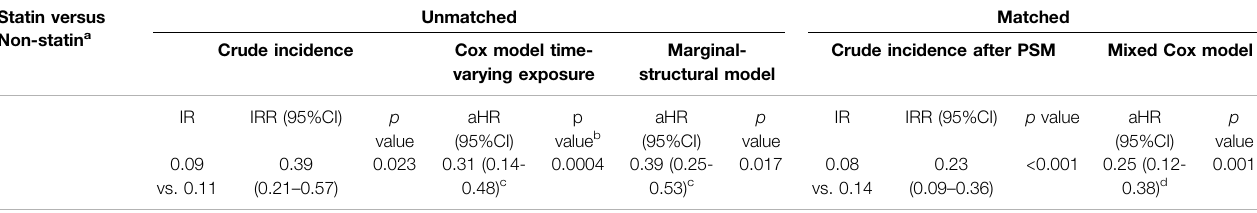
TABLE 6 | Incidence rate and hazard ratios to evaluate the association between in-hospital statin therapy and mortality. Statin versus Non-statin a